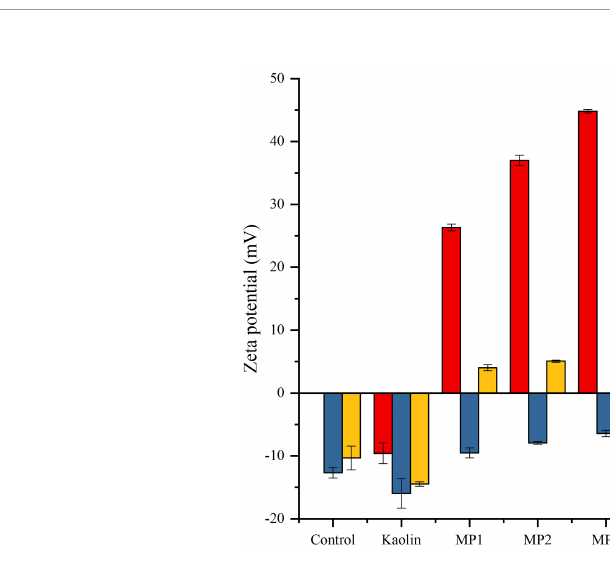
FIGURE 7 Effects of two modi fi ed clays on the zeta potential of pure water, P. donghaiense and natural